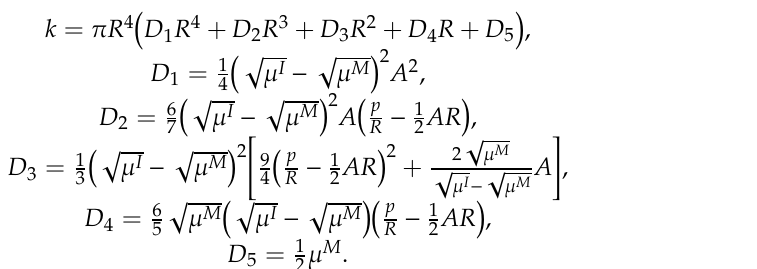
Figure 9. ( a ) Changes of volume fraction ξ along radius ρ of the bar; ( b ) torque versus unit angle of twist.